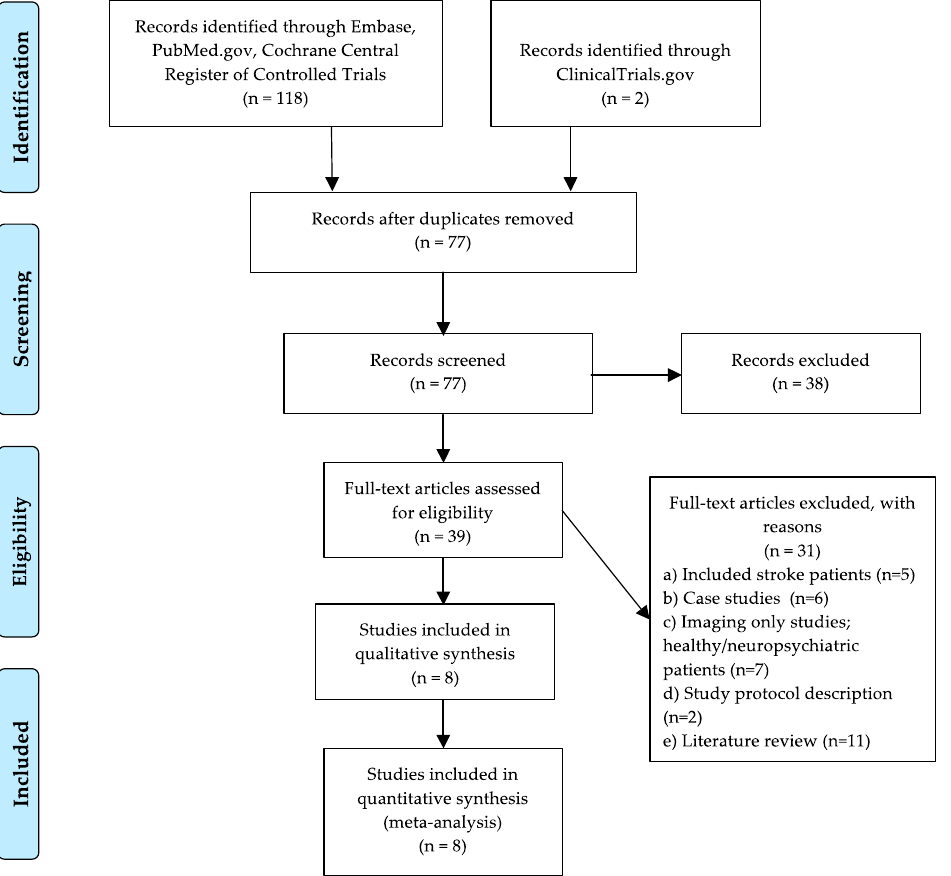
Figure 1. Preferred Reporting Items for Systematic Reviews and Meta-Analyses (PRISMA) flow diagram for the selection of studies.